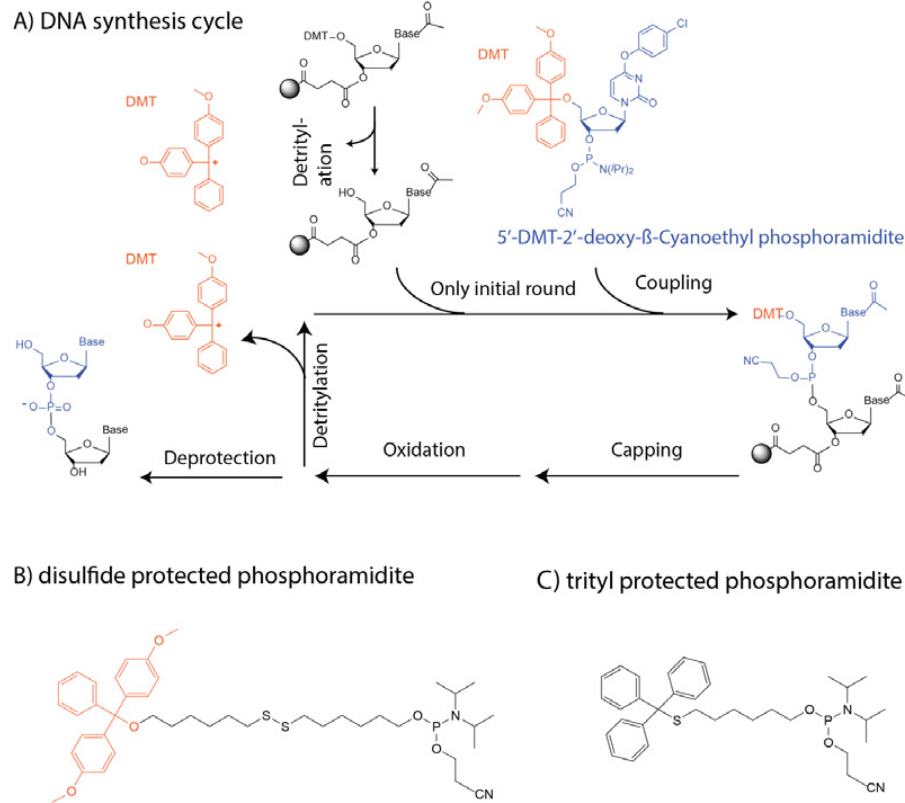
Fig. 1. Schematic representation of DNA oligo synthesis procedure and its building blocks. A) The synthesis cycles start with removal of DMT group (deteritylation) from a surface attached phosphoramidite and continues with cycles of coupling, capping, oxidation and detritylation of a newly arriving phosphoramidites. Final round finishes with deprotection of the synthesized oligo i.e. separation of the synthesized oligo from the solid resin and base protection groups. As an example a standard cytosine phosphoramidite is depicted in blue color in this figure. All DMT groups are marked in orange color. B and C) phosphoramidites that are incorporated in synthetic oligonucleotides for 3’ and 5’ end labeling of DNA with thiol group. The disulfide protected form is utilized often and the trityl protected form is used rarely